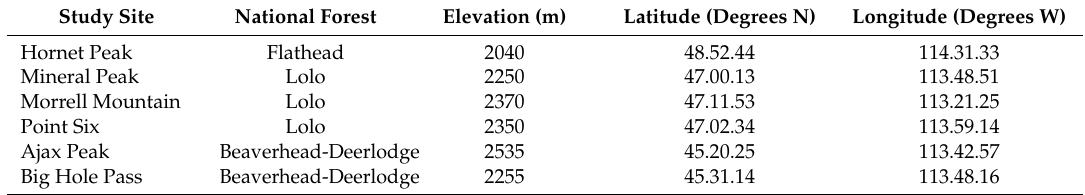
Table 1. Locations of whitebark pine study sites located along a north-south transect in western